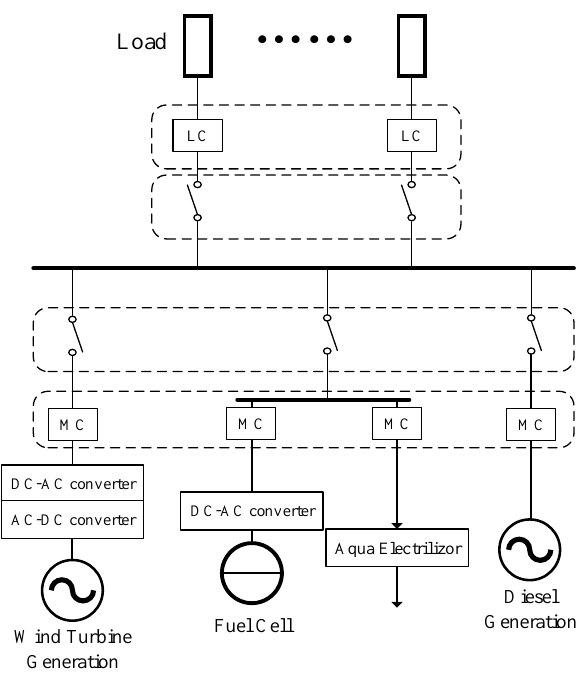
Figure 1. Islanded AC Microgrid Power System.